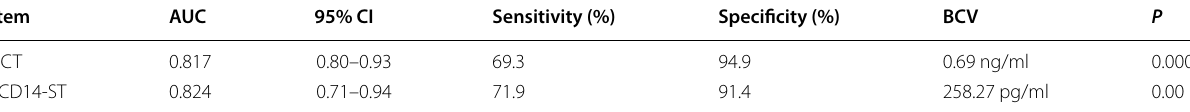
AUC area under the ROC curve, BCV best critical value, PCT procalcitonin, sCD14-ST soluble CD14 subtype P < 0.05 was considered statistically significant